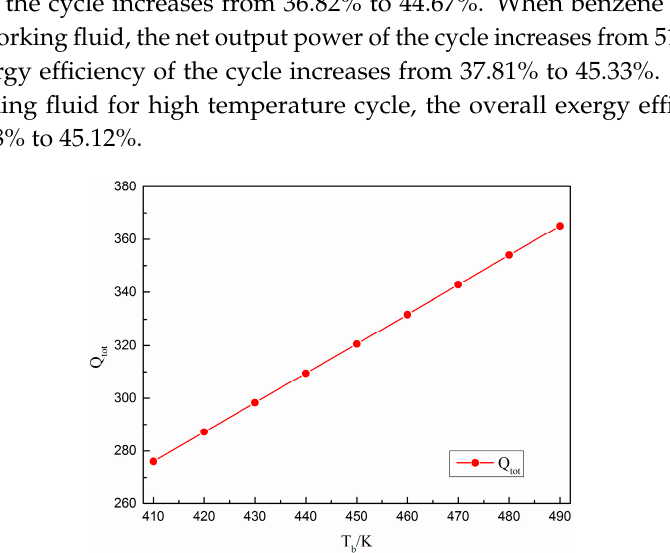
Figure 8 . Effect of T b on total heat absorption of high and low temperature cycle evaporators.